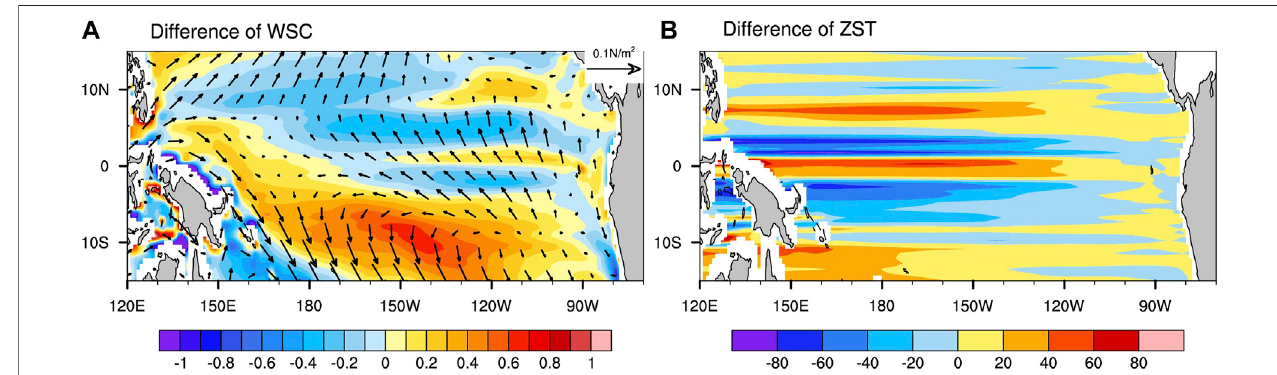
FIGURE 7 | (A) The difference in annual mean WSC (shaded, in *10 – 7 N/m 3 ) and wind stress vector (arrows, in N/m 2 ) between SST-Assim experiment and SST- noAssim experiment (SST-Assim minus SST-noAssim); (B) the difference in annual mean zonal Sverdrup transport (shaded, in m 2 /s) between SST-Assim experiment and SST-noAssim experiment (SST-Assim minus SST-noAssim) and the positive values indicate an eastward direction. The average period of the model data is from 1982 to 2014.